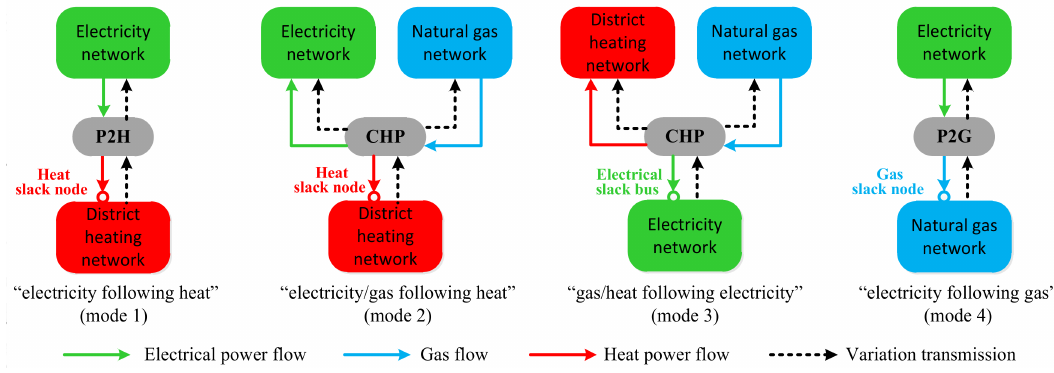
Figure 2. Schematic diagrams of the four typical operation